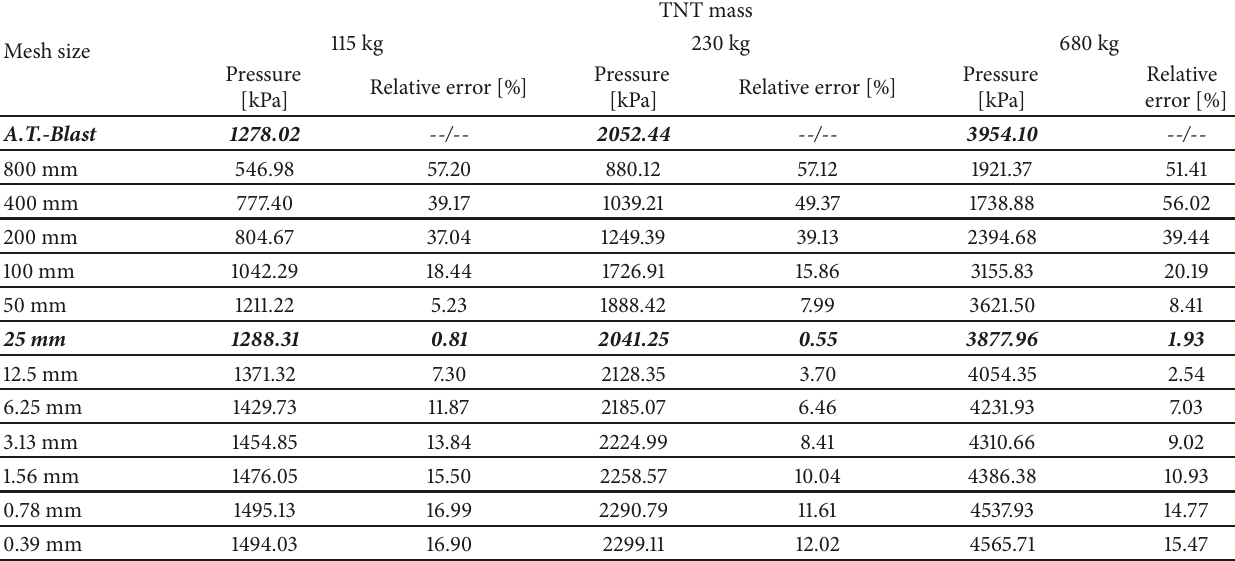
Table 7: Comparison of maximum incident pressures in dependency of air mesh size for a gauge point at the range of 5 m.